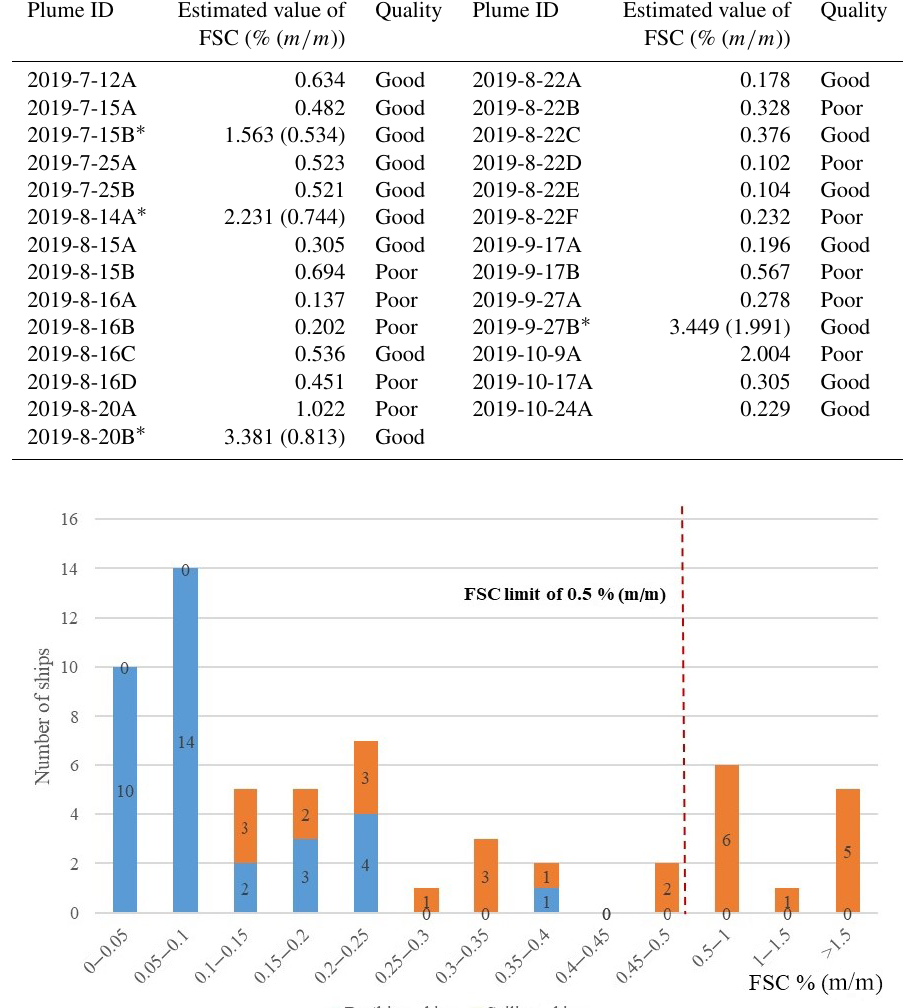
Figure 6. Comparison between the monitoring results of berthing ships and sailing